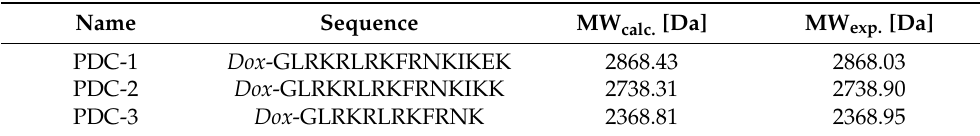
Scheme 1. Synthesis scheme of Dox-SMP-peptide conjugates. Exemplarily, the synthesis of PDC-2 is shown (see also Table 2 for peptide sequence). Table 2. Names, sequences and molecular weights of synthesized peptide-drug conjugates, PDC-1, PDC-2 and PDC-3, having coupled doxorubicin at the N -terminal via an SMP linker.